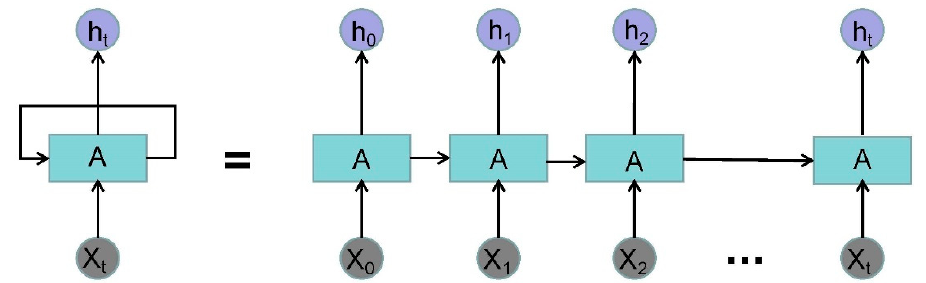
Figure 5. The expansion structure of recurrent neural networks (RNN). (Where X t is the input data of time t and h t is the output data of time t .)